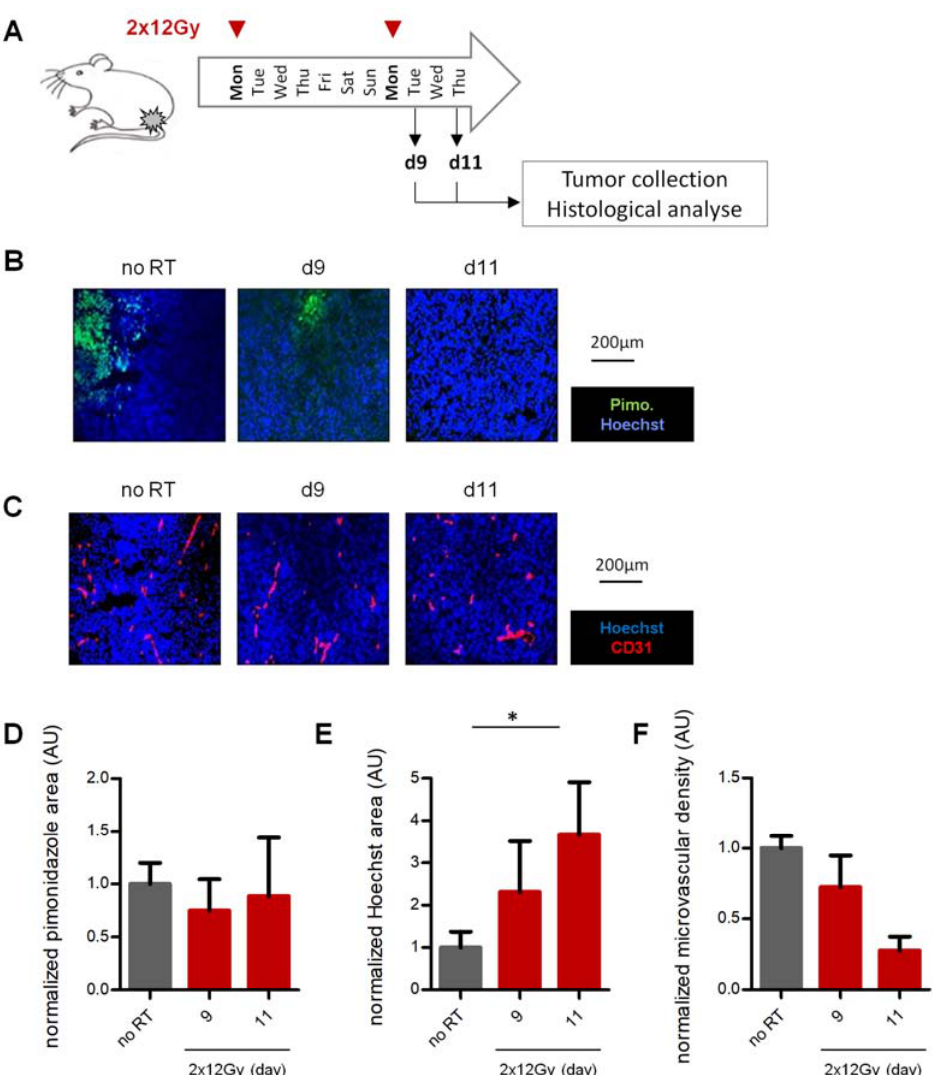
Figure 4. Time window of vascular changes after 2 × 12 Gy in LLC tumors. ( A ) Fractionation